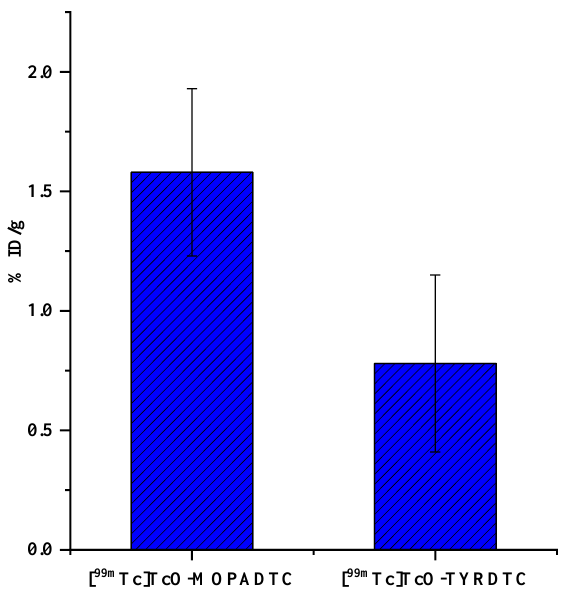
Figure 5. Comparison in tumor uptake at 4 h post-injection ( n = 5) of [ 99m Tc]TcO-MOPADTC and [ 99m Tc]TcO-TYRDTC.